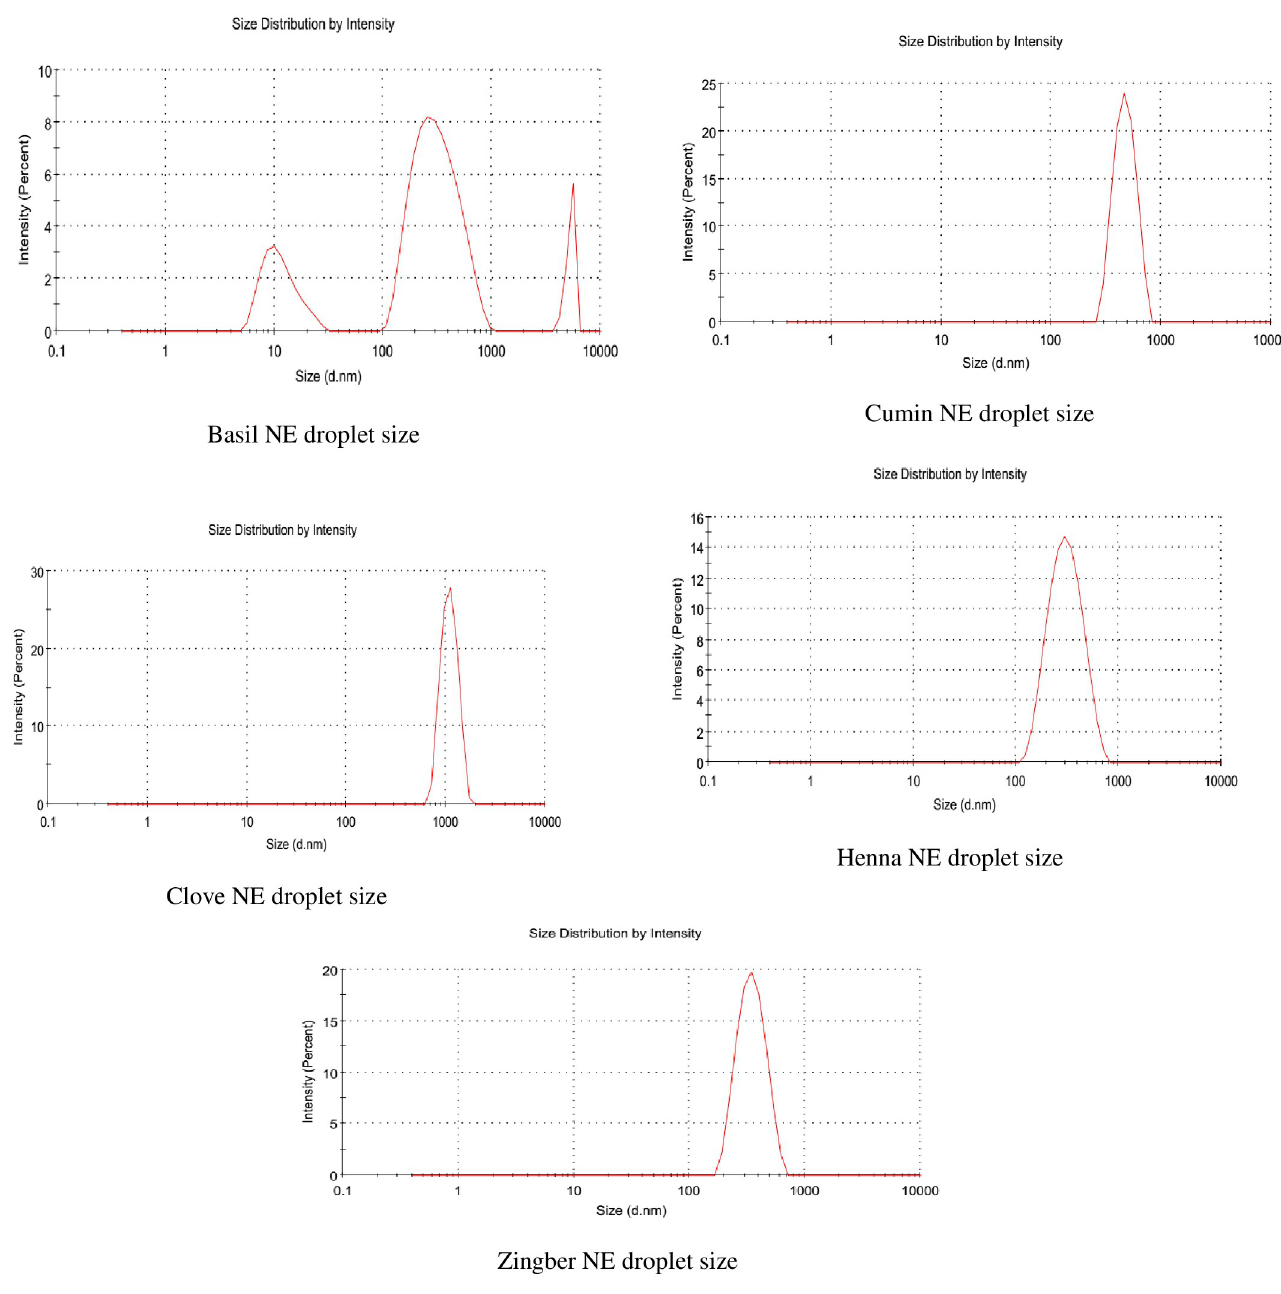
Fig 2. Droplet size of different essential oils